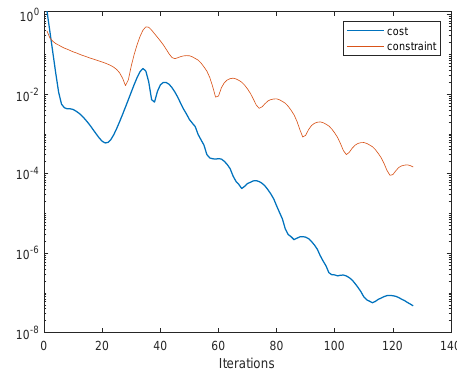
Figure 4. Trajectories convergence of ααα t .